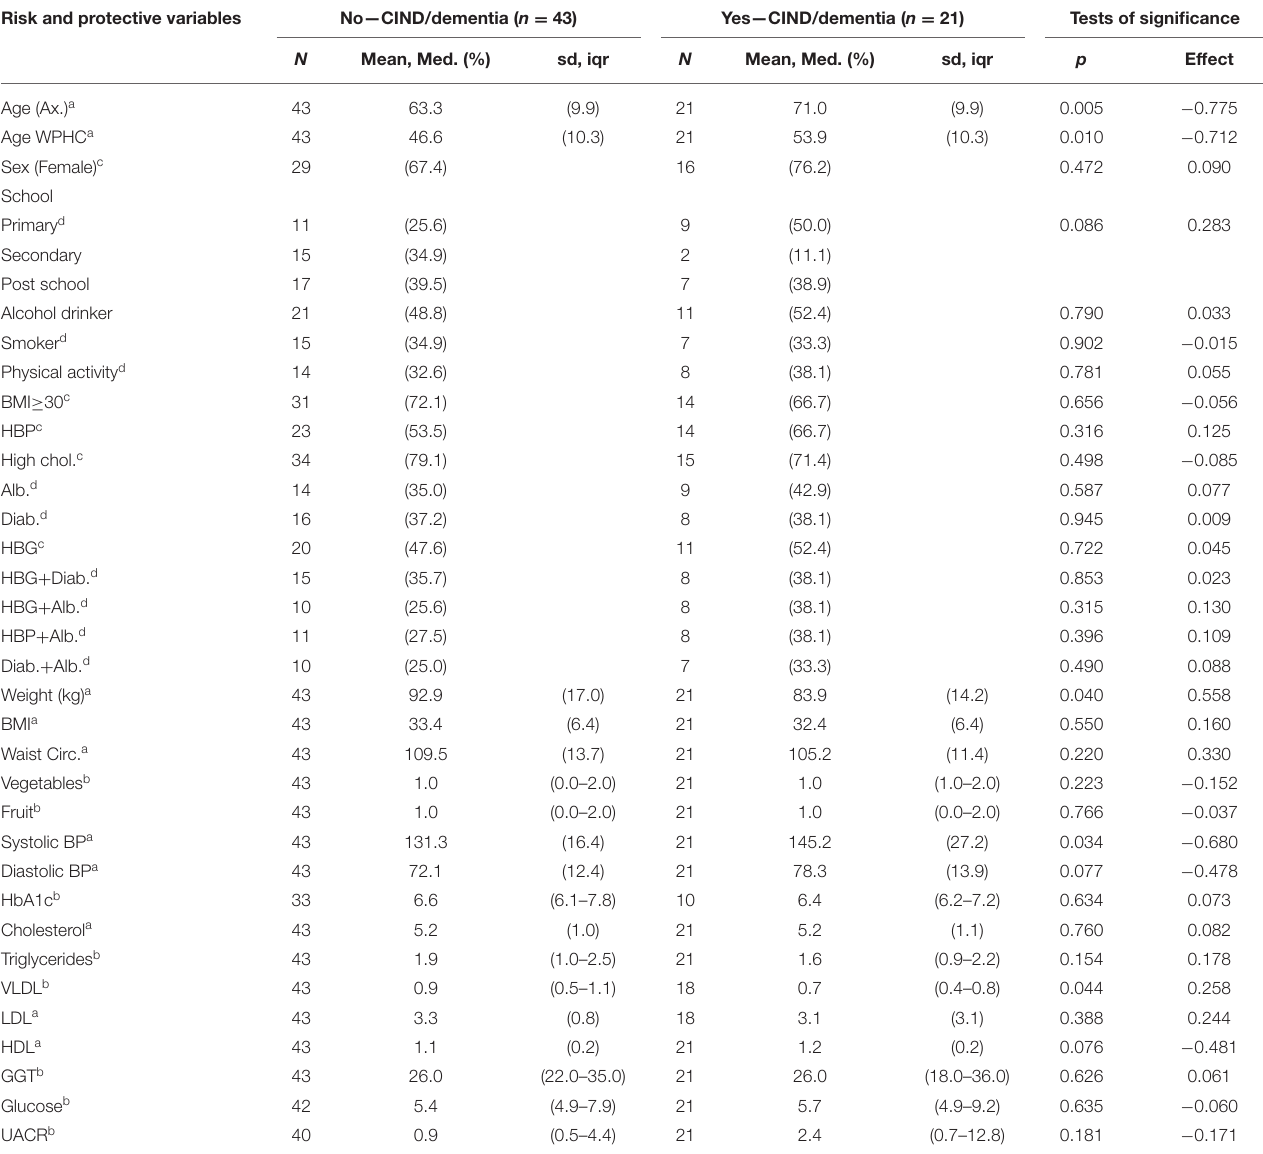
TABLE 1 | Earliest recorded risk and protective factors for Cognitive Impairment Not Dementia (CIND) or dementia, among 64 Aboriginal and Torres Strait Islander residents who participated in the Well Person’s Health Check (WPHC) (1998/2000, 2005/2006), by dementia status at follow up